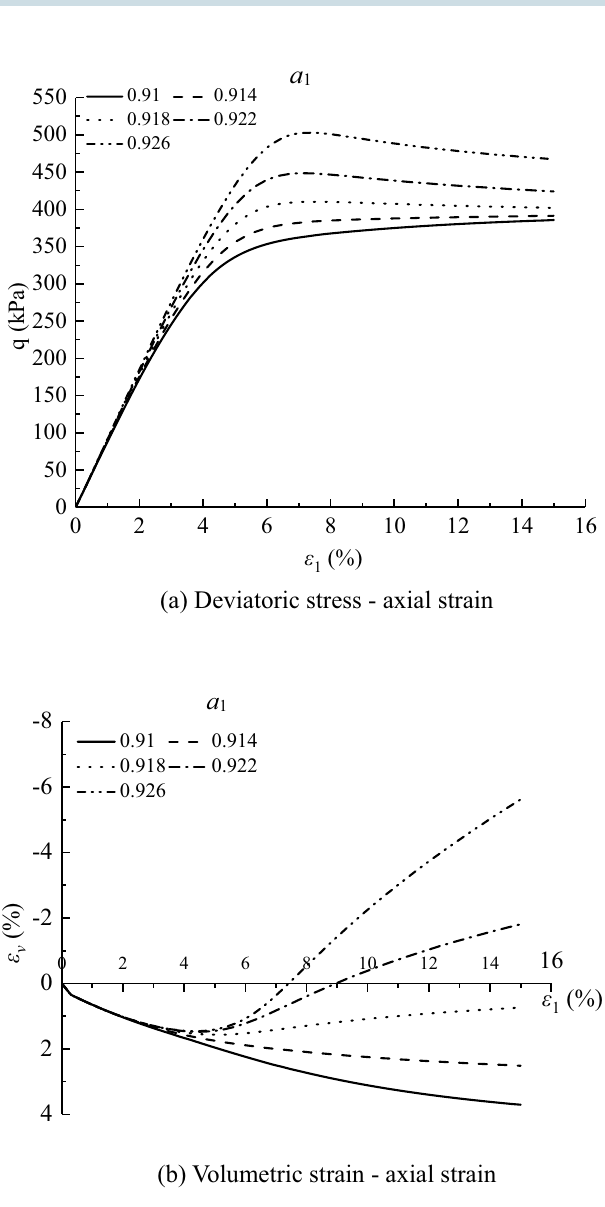
Figure 12. Sensitivity analysis of simulation results with varying a 1